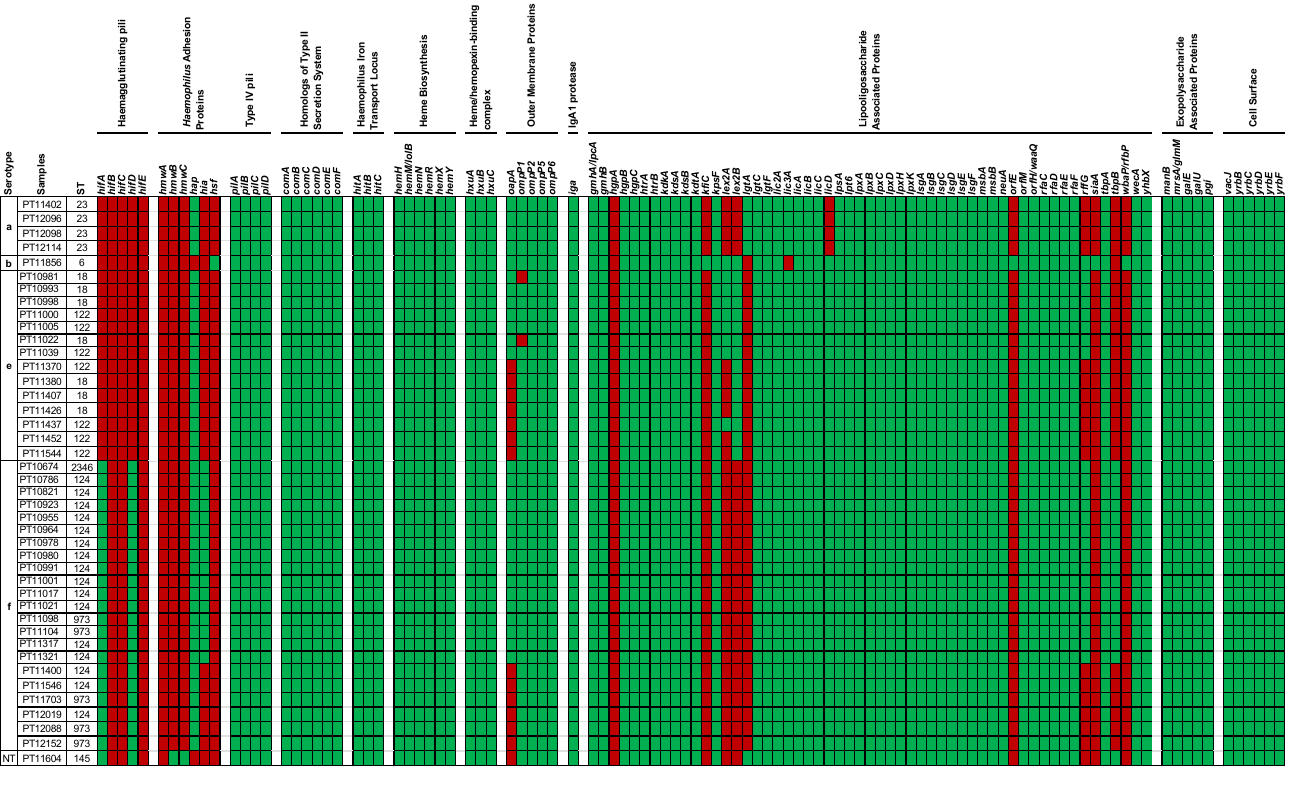
Figure 1. Detection of presence/absence of 105 virulence genes of H. influenzae that are described in [53,54]. Each line corresponds to a single isolate. The thicker borders delimit different serotypes. The first, second and third columns correspond to serotype, sample number and sequence type, respectively. Each other column corresponds to a single gene. Green squares show that the gene was detected. Red squares show that the gene was not detected.